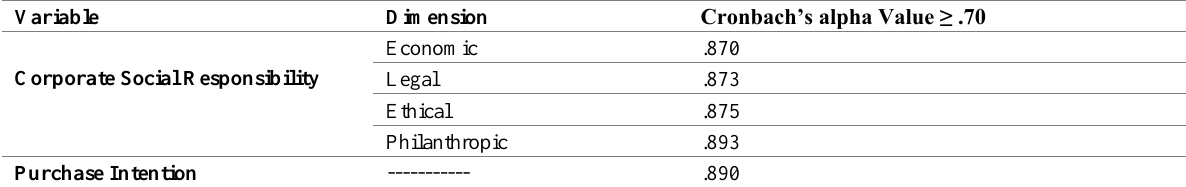
Table 10: Reliability Test Results of the Measurement Instrument (n=188)